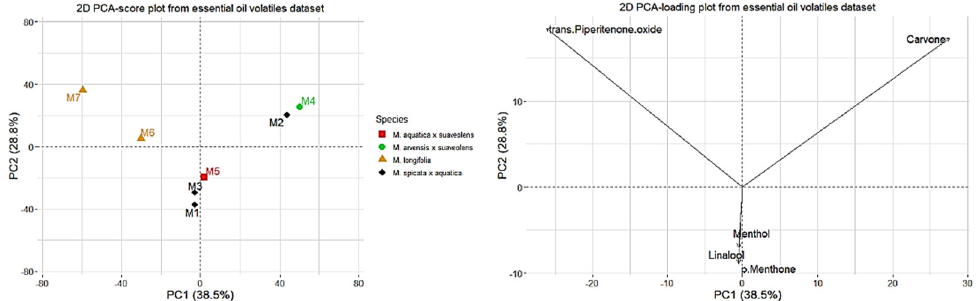
Figure 3. Principal component analysis (PCA) scores ( left ) and loadings ( right ) (only first five variables with the highest contributions are shown) plots based on essential oil volatiles dataset.